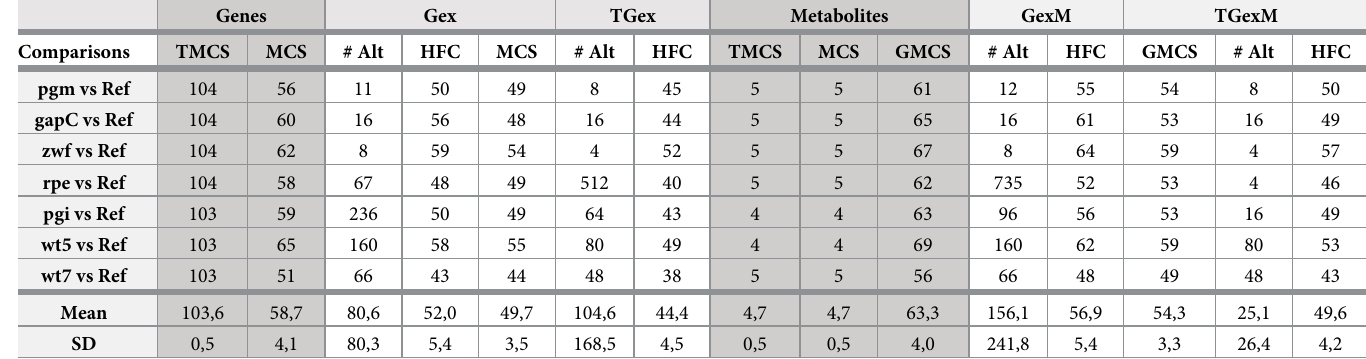
Table 1. Maximum consistency score and the number of alternative solutions for different models. The reference refers to the wildtype growth rate of 0.2/hour. Gens and Metabolites represent the number of differentially regulated genes and metabolite between two conditions, respectively. TMCS, theoretical maximum consistency score; MCS, maximum consistency score; # Alt, number of alternatives; HFC, high frequency constraint. SD represents the standard deviation across comparisons.